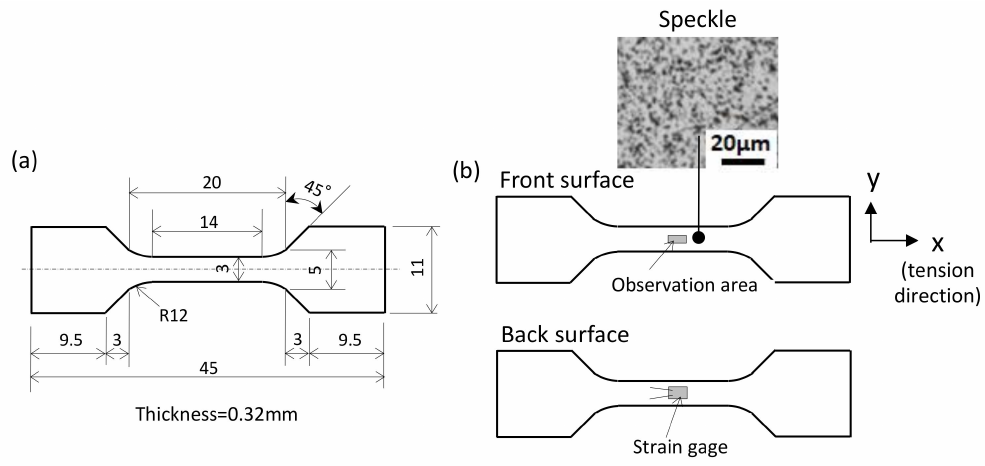
Figure 1. ( a ) Tensile specimen size (unit: mm); ( b ) strain gauge position, observation position and speckle on the front surface.